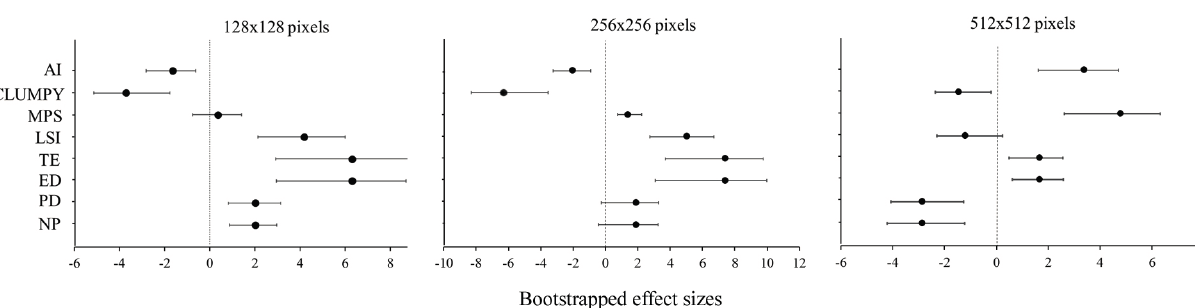
Figure 4. Effect size estimations. Mean values and 99% confidence intervals of the effect sizes estimation (10,000 bootstrap resampling) are reported. The vertical dashed lines represent an effect size of zero. For pattern metric acronyms, refer to Table